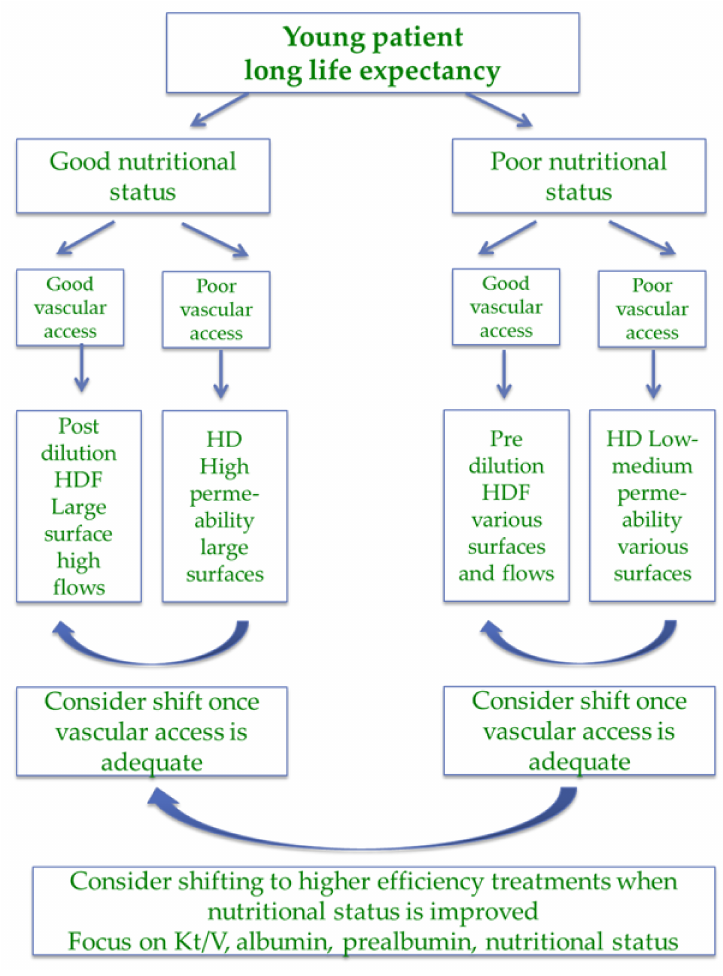
Figure 3. Choice of dialysis (hemodialysis (HD) or hemodiafiltration (HDF)) in the “ideal